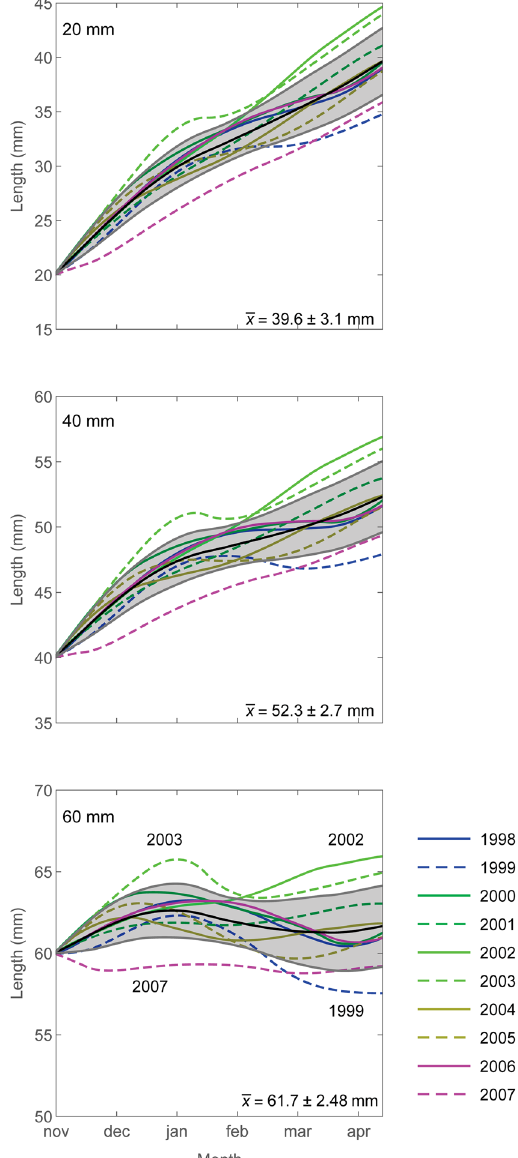
Figure 5. Growth curves (November to mid-April) from 1998 to 2007 at 54°S, 40°W for krill with initial sizes of 20 mm, 40 mm and 60 mm (1998 = austral summer 1997/1998). The colours show the growth curves for different years (see lower panel for key and annotation) along with the mean (black) and standard deviation (grey shading). Mean + / − 1 standard deviation of the krill length by ~mid April (13 th April) are shown. Figure created using Wolfram Mathematica version 11